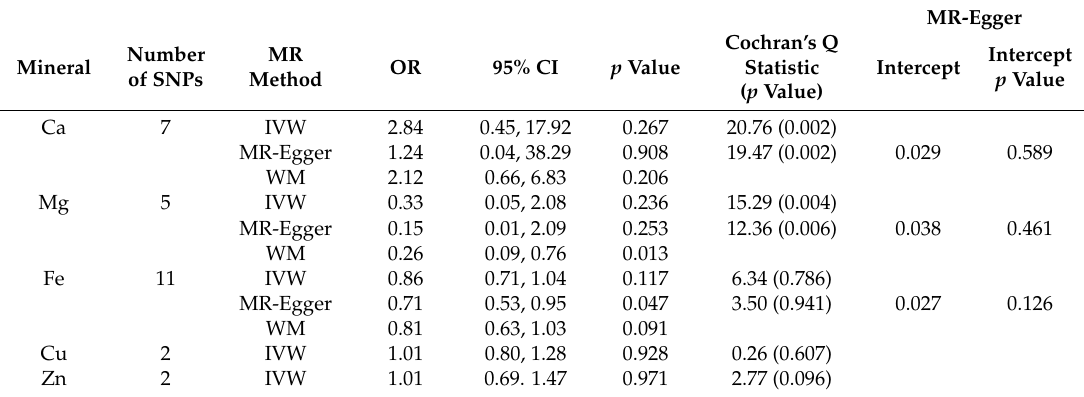
Table 4. MR estimates of the causality between five minerals and gout.